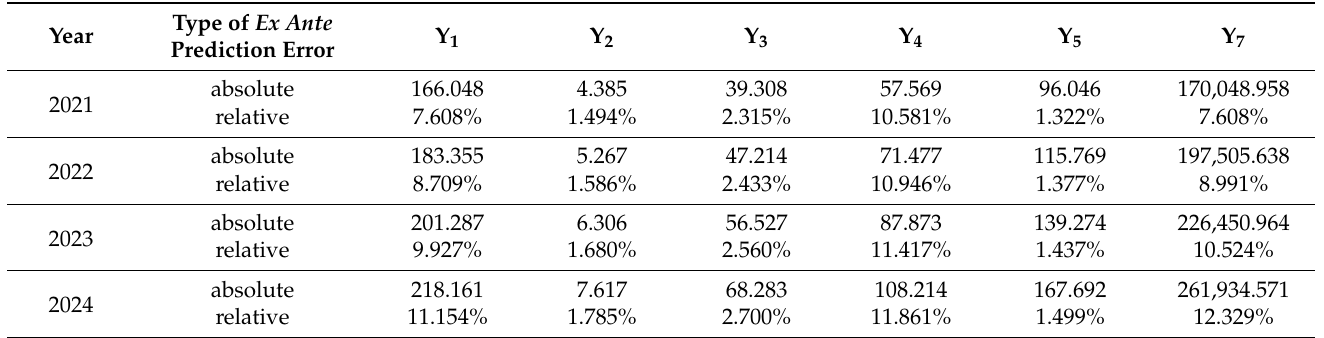
Table 10. Average and relative ex ante prediction error for forecasts generated from a cause-and- effect